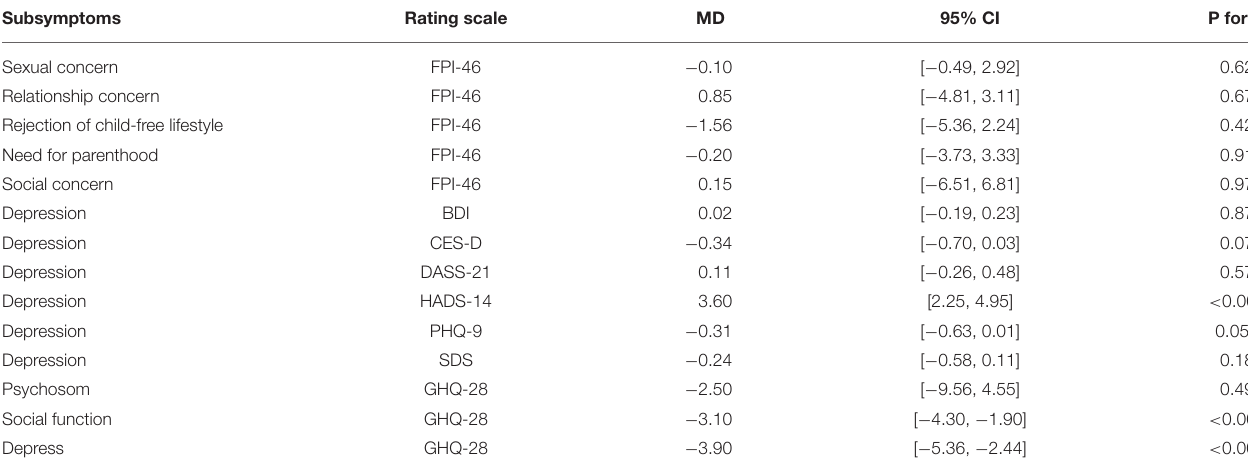
TABLE 3 | Subsymptoms of psychological scores using different measurements.